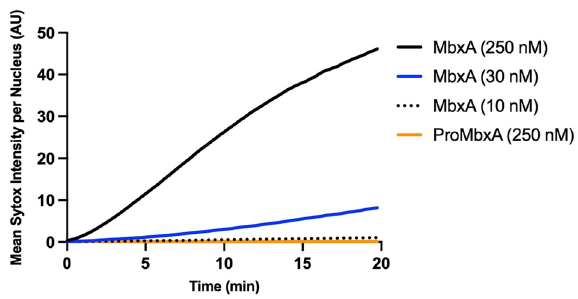
Figure 10. Quantification of MbxA-induced permeabilization of HEp-2 cells. Mean Sytox Green intensity per nucleus of HEp-2 cells (y-axis) was continuously measured over a period of 20 min at 37 °C (see mateirals and methods for details) and is plotted against time (x-axis) for different MbxA concentrations (250 nM, 30 nM and 10 nM) and 250 nM. Sytox Green staining of the HEp-2 cells´ DNA is faster and more intense when 250 nM MbxA were used and is reduced at lower MbxA concentrations (30 nM and 10 nM). In contrast to that, no significant Sytox Green staining of the nuclear DNA was observed with 250 nM proMbxA (number of nuclei used for quantification: 250 nM MbxA—71, 30 nM MbxA—74, 10 nM MbxA—79, 250 nM proMbxA—62). Nuclei have been analyzed from two independent experiments with two biological replicates each. The original images at different time points are provided in Fig.